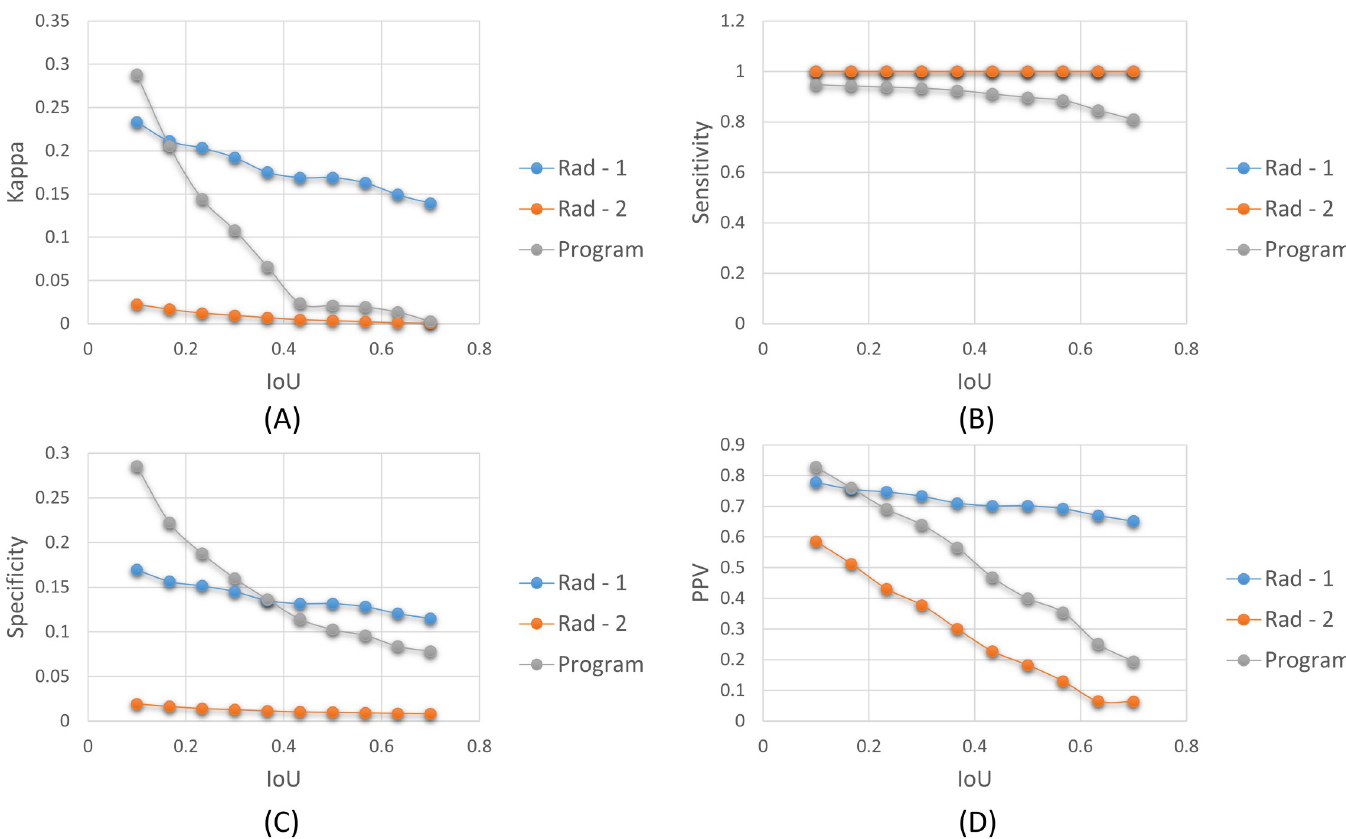
Fig 17. Assessing inter-reader variability and program performance. The following performance metrics are measured and plotted for 10 different IoU thresholds in the range (0.1–0.7): (A) Kappa statistic; (B) Sensitivity; (C) Specificity; (D) PPV.